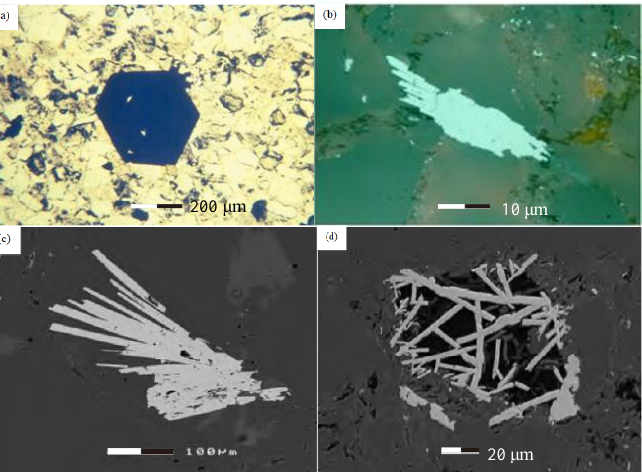
Figure 1. ( a ) Hematite in a thin section illustrating a euhedral hexagonal crystal form; ( b ) hematite outgrowths aligned in the fabric defined by strain fringes on quartz grains; ( c ) hematite plates partly filling a grain-shaped cavity; ( d ) hematite grain with large radiating blades. ( a ) is reprinted with permission from Ref. [44]. 2013, Turkish Journal of Earth Sciences; ( b – d ) are reprinted with permission from Ref. [45]. 2019,